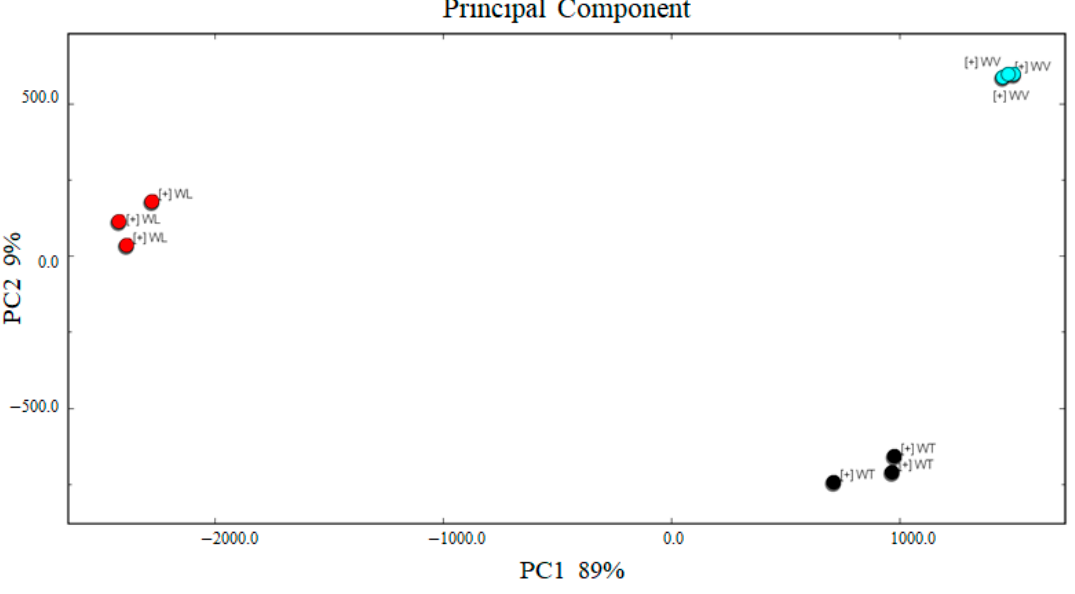
Figure 8. The scores plot of PCA analysis in cherry wines derived from three cultivars.